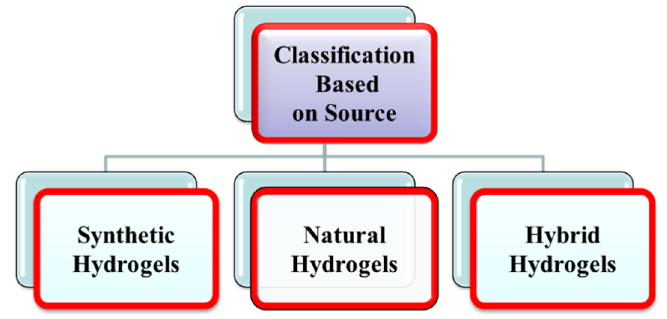
Figure 1. Classification of hydrogels based on source.